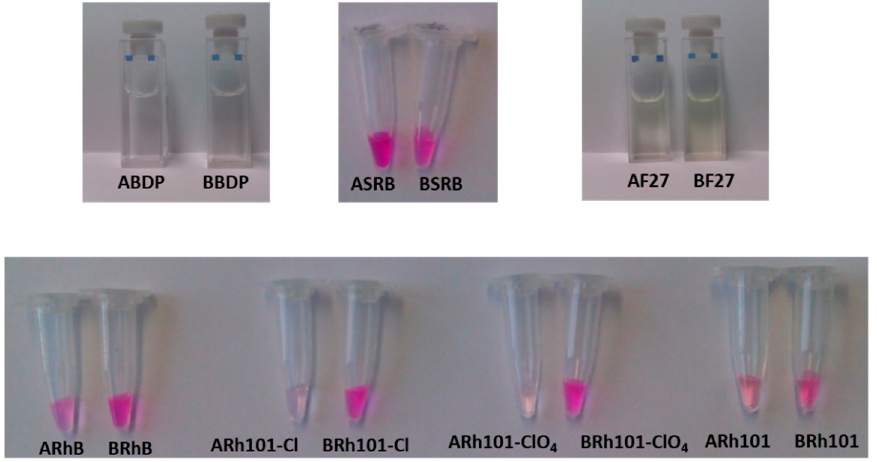
Figure 7. Photographs of released dye in the supernatant after centrifugation of suspensions of the 14